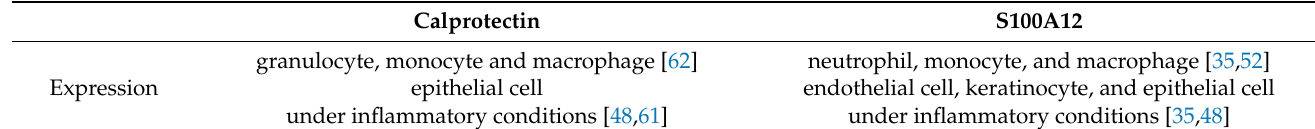
Table 2. Characterization of Calprotectin (S100A8/S100A9) and